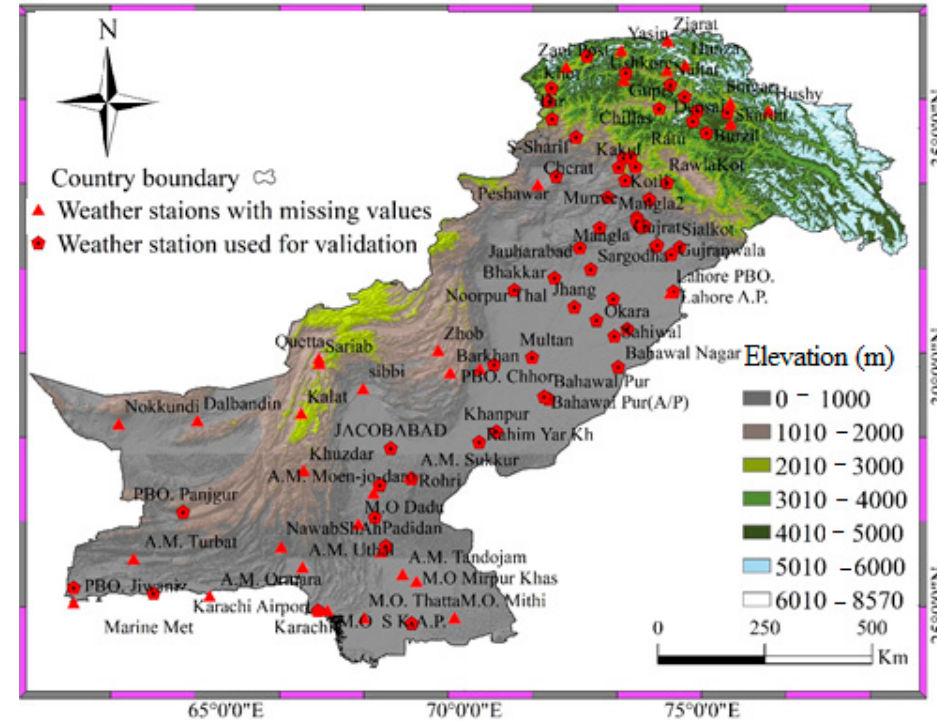
Figure 1. Topographical map of Pakistan with locations of metrological stations. Table 1. Salient features of the gauging stations considered for the validation of